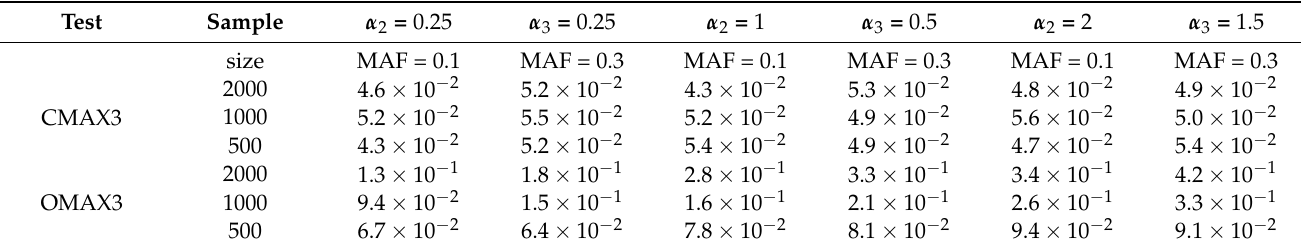
Table 2. Empirical type I error rates of CMAX3 and OMAX3 with nominal levels